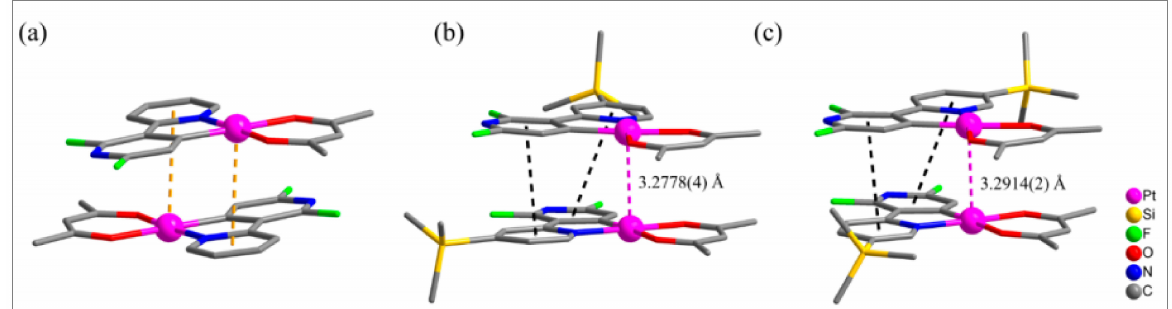
Figure 7. Dimeric structures of complexes 23 (R = none, 4/5-TMS) formed via Pt ··· π (yellow-dashed lines), π − π (black- dashed lines), and Pt ··· Pt (violet-dashed lines) interactions. H atoms were omitted for clarity. ( a ) R = none; ( b ) R = 4-TMS and ( c ) R = 5-TMS. Reproduced with permission from ref.